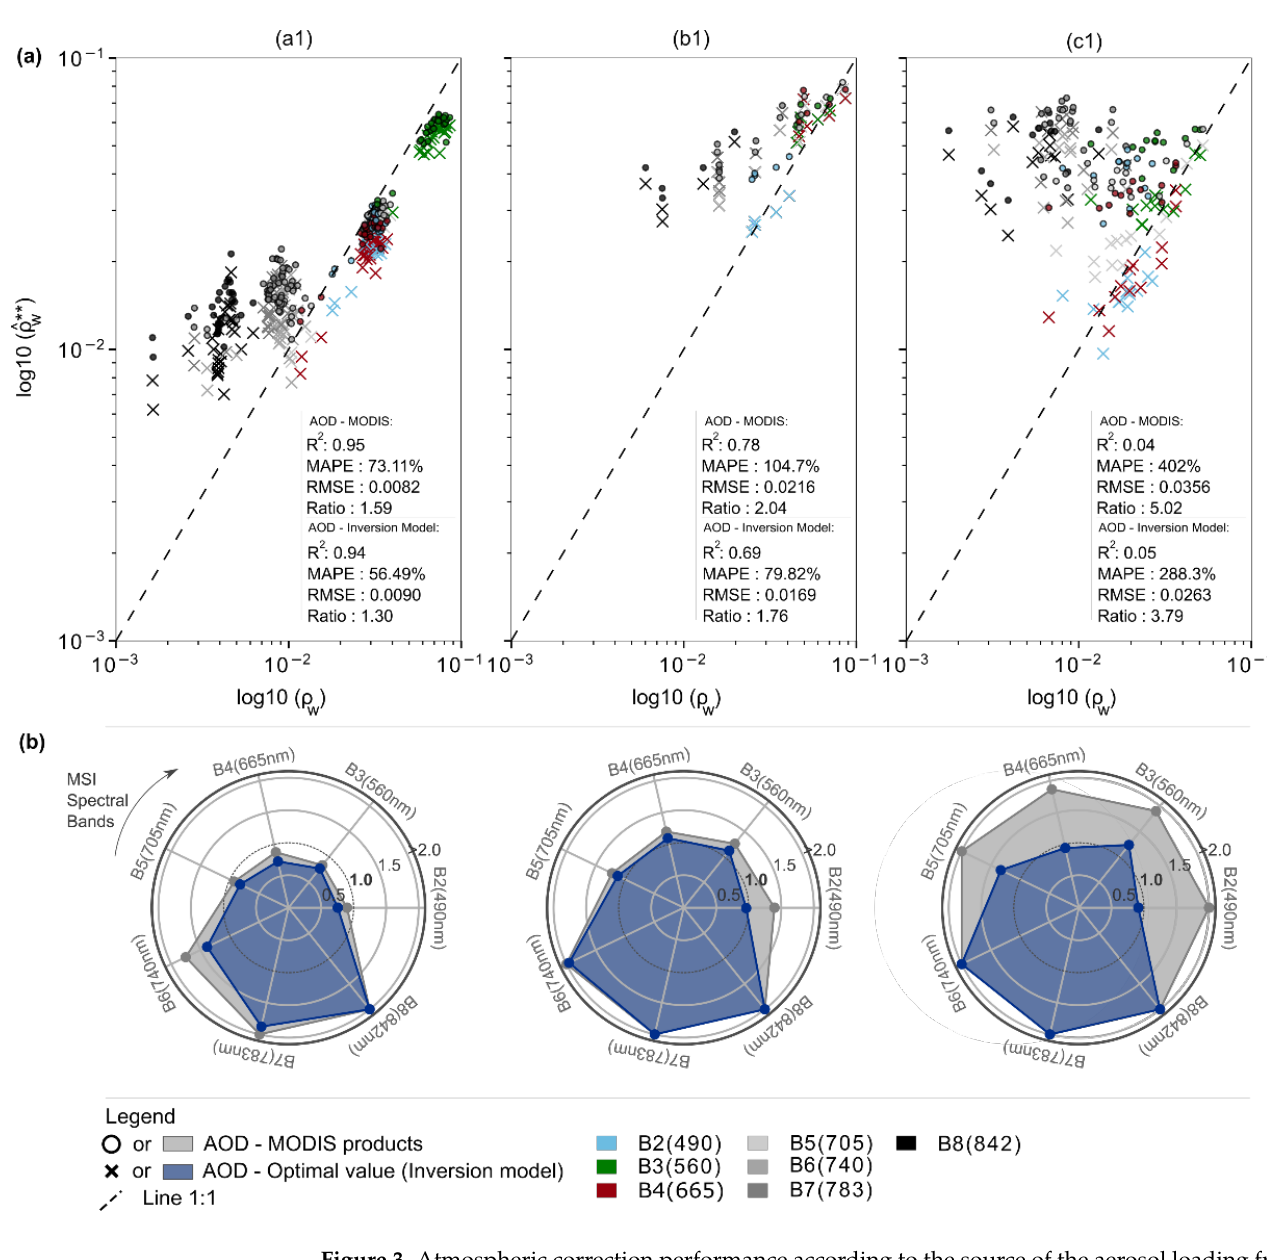
Figure 3. Atmospheric correction performance according to the source of the aerosol loading from the inversion model versus MODIS aerosol optical depth at 550 nm for ( a ) all MSI spectral bands and ( b ) the average ratio per MSI band. Atmospheric correction was performed for the different water optical types: ( a1 ) eutrophic (N = 28), ( b1 ) bright (N = 5), and ( c1 ) dark (N = 13) waters.